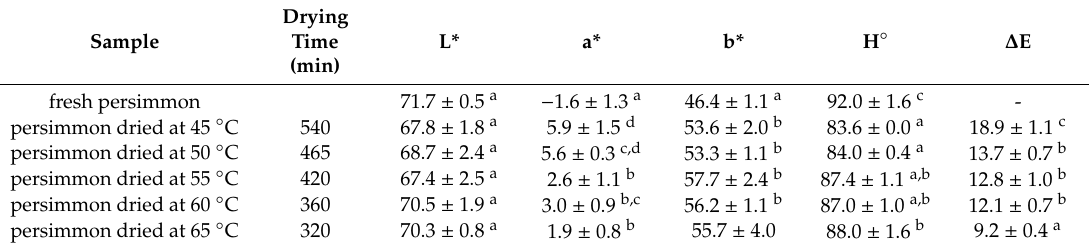
Table 5. Colour parameters (lightness / darkness L*; redness / greenness a*; yellowness / blueness b*; Hue angle H ◦ ; total colour di ff erence ∆ E) for fresh and dried persimmon